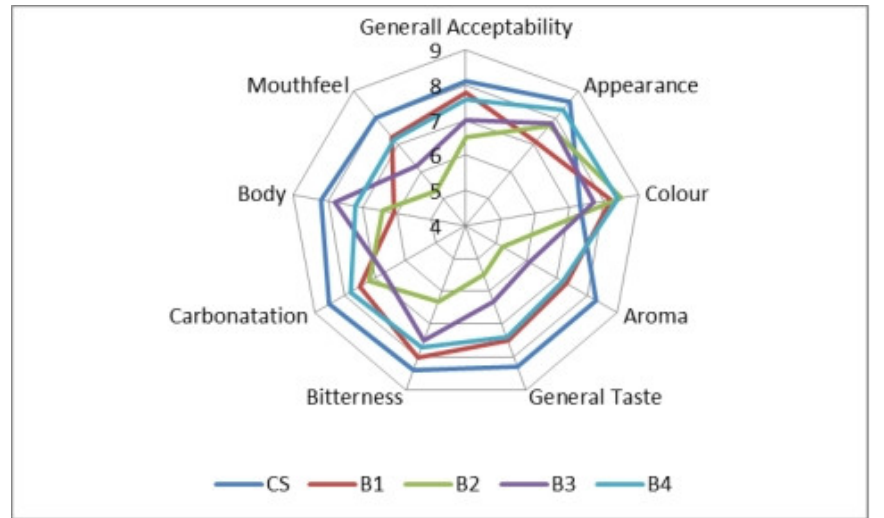
Figure 6. Sensory characteristics of the beer samples.